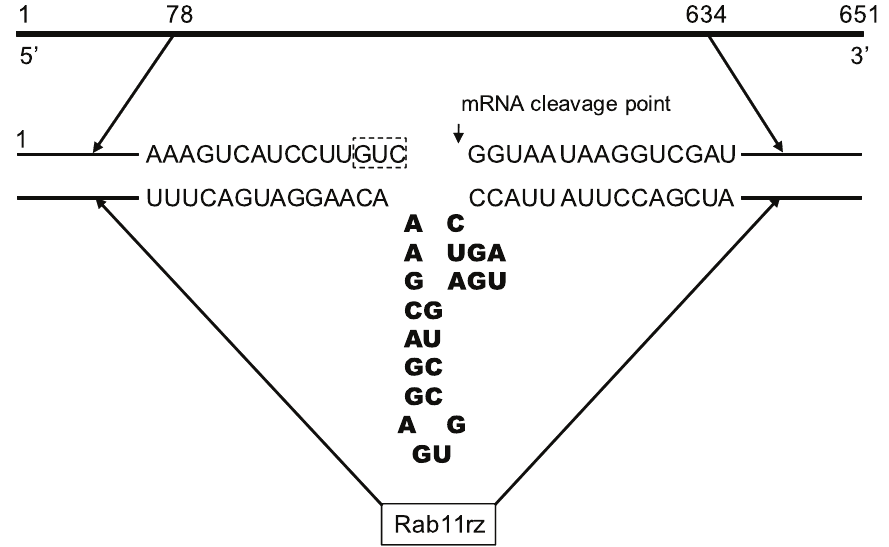
Figure 1. Schematic representation of the Rab11 hammerhead ribozyme. Bold letters show the ribozyme structure, the dotted box indicates the nucleotides selected as a cutting site.